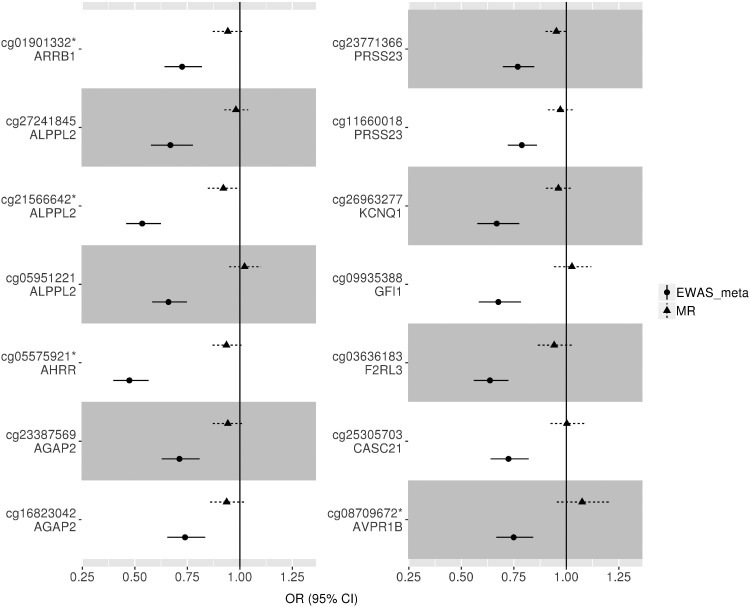
Mendelian randomization (MR) vs observational analysis. Two-sample MR was carried out with methylation at 14/16 CpG sites identified in the EWAS meta-analysis as the exposure and lung cancer as the outcome. cg01901332 and cg05575921 had two instruments, so the estimate was calculated using the inverse variance weighted method; for the rest, the MR estimate was calculated using a Wald ratio. Only 14 of 16 sites could be instrumented using mQTLs from [mqtldb.org]. OR, odds ratio per SD increase in DNA methylation. *Instrumental variable not replicated in independent dataset (NSHDS). The sites for which instrumental variables have not been replicated are cg01901332, cg21566642, cg05575921 and cg08709672.